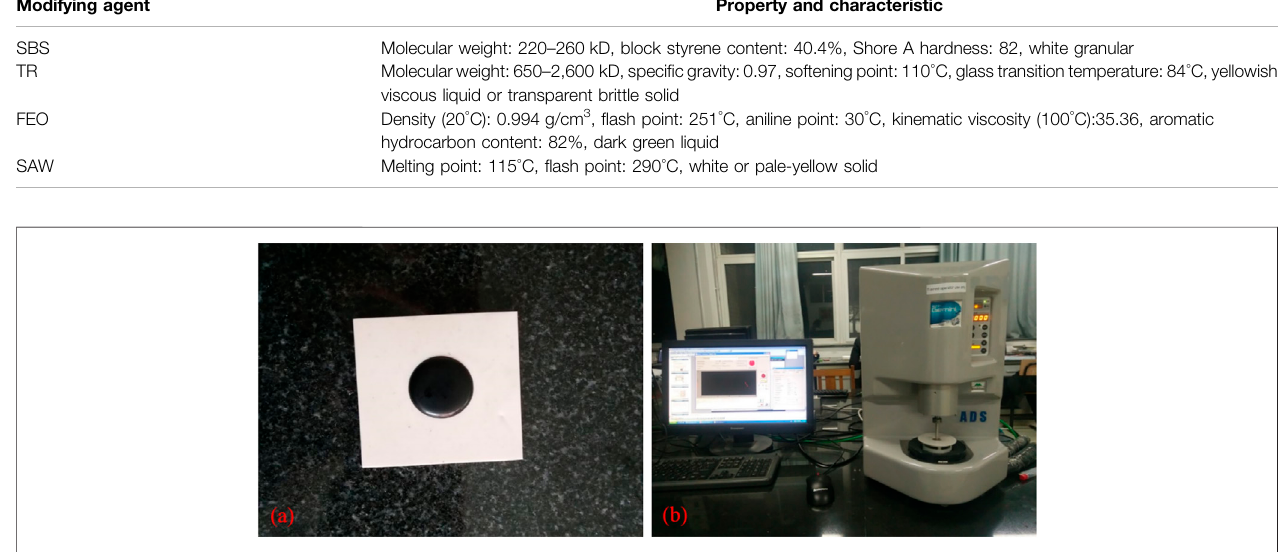
FIGURE 1 | (A) The preparation of specimens and (B) the DSR